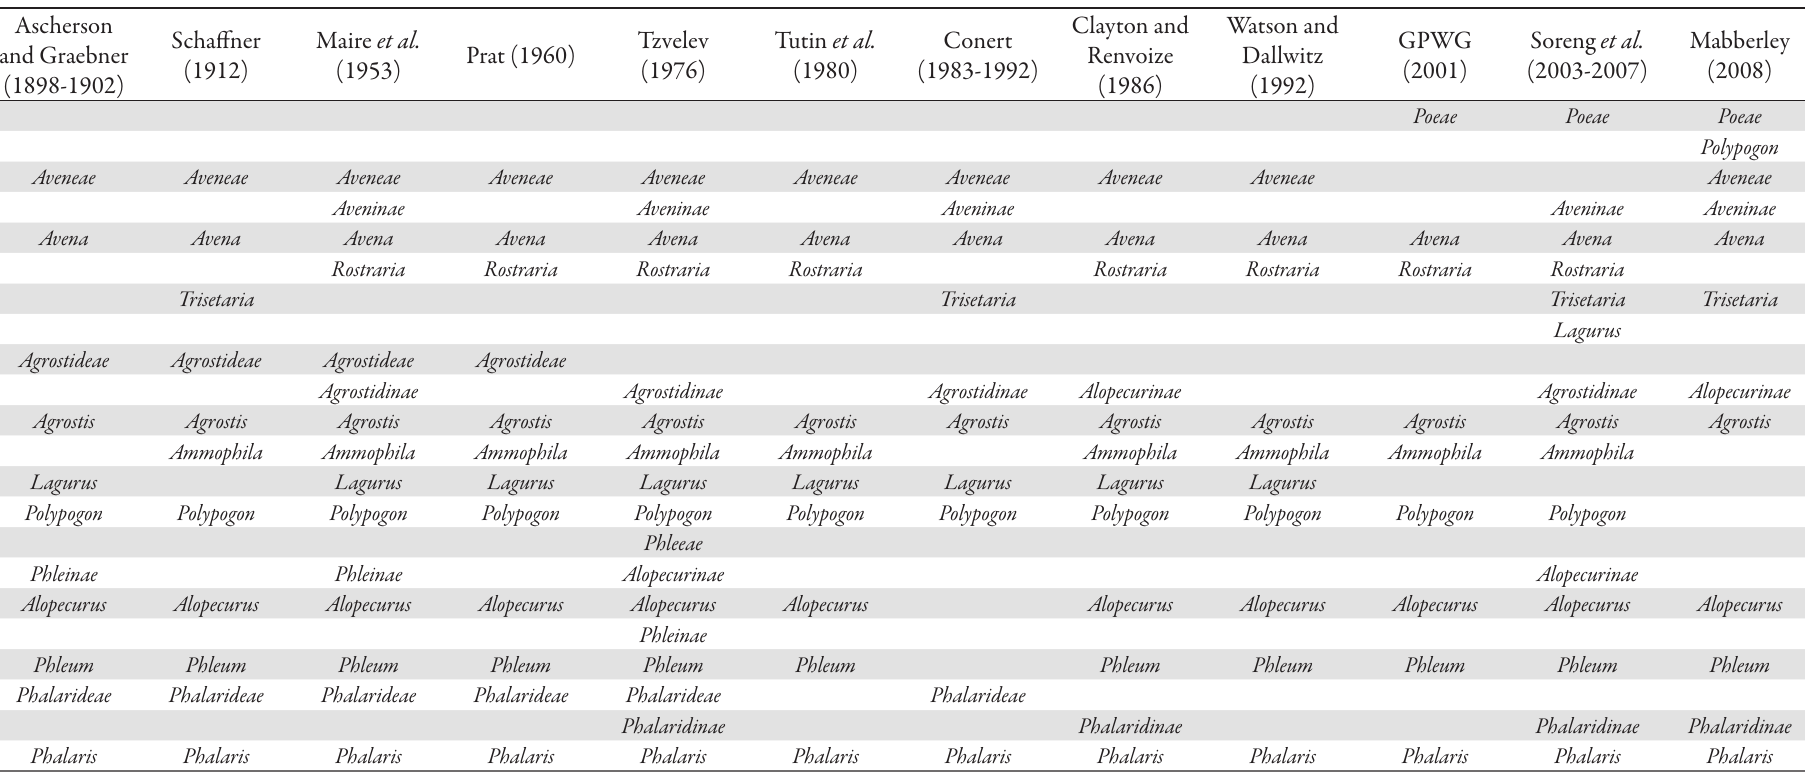
Tab. 1. Placement of the Aveneae representatives included in our study in selected classification